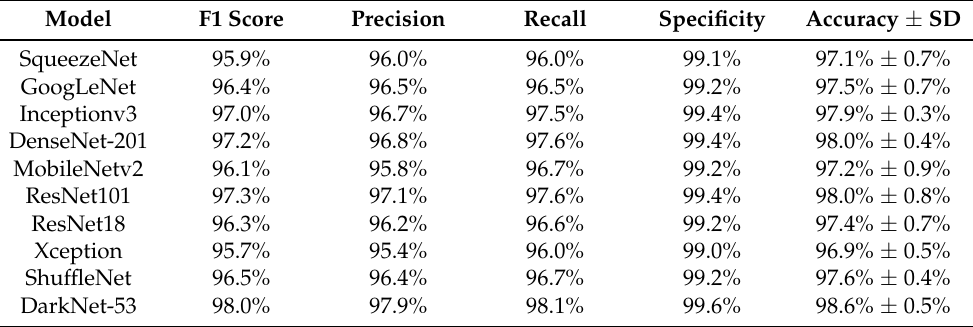
Table 4. The mean overall F1 score, precision, recall, specificity, and accuracy using 90% of the data for training. The results are an average of 10